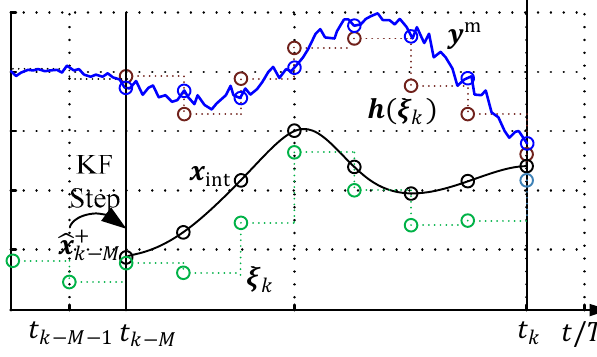
Figure 9. Schematic representation of a moving measurement window.